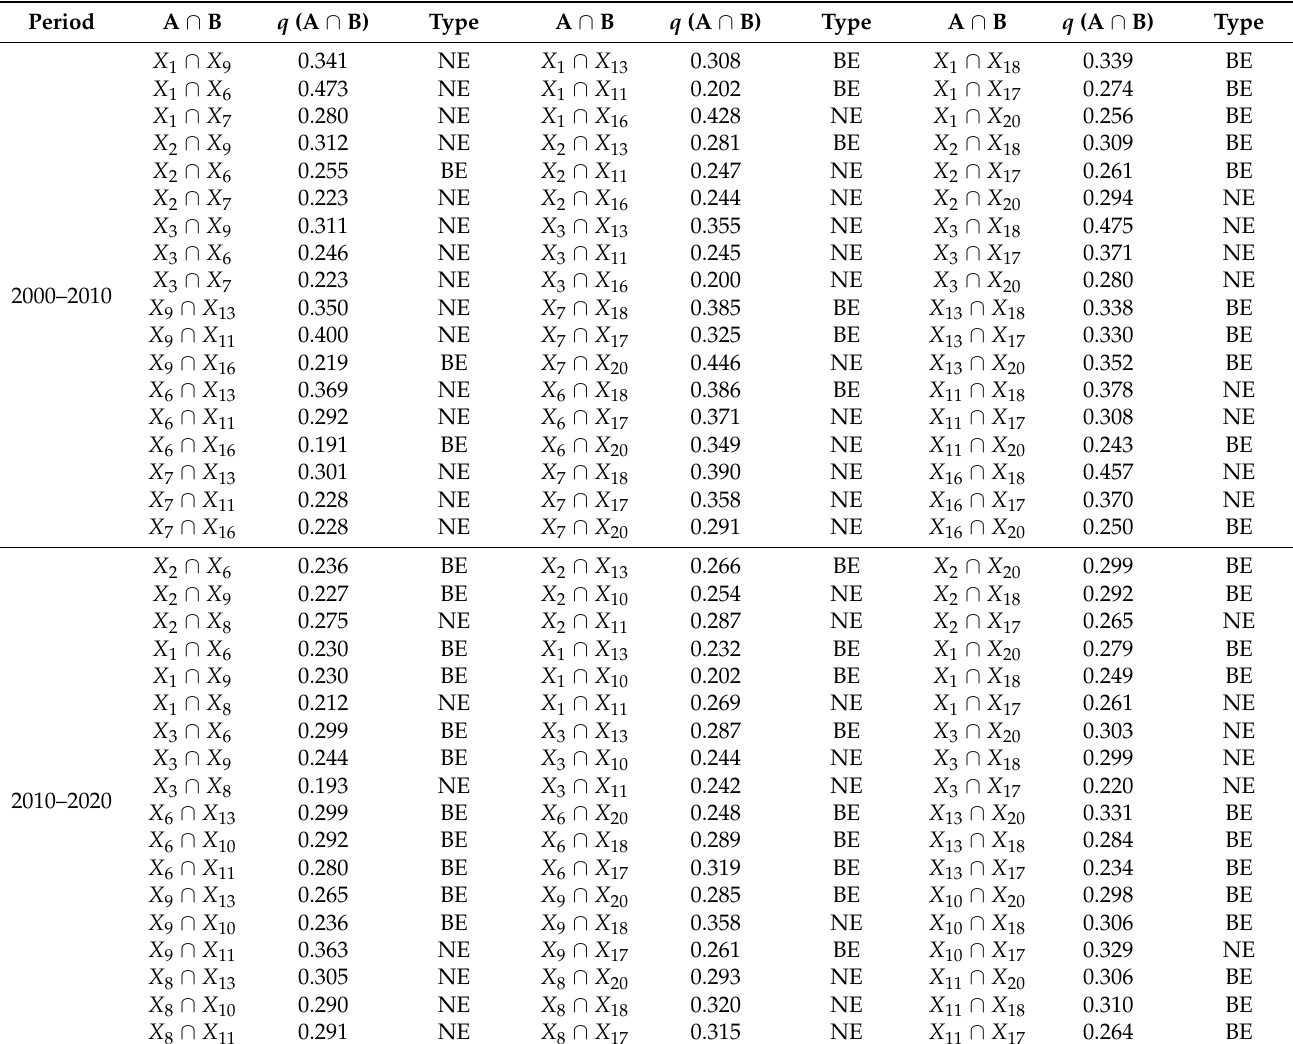
Table 6. Interaction detection results for factors influencing population shrinkage by time period in the North–South Transitional Zone of